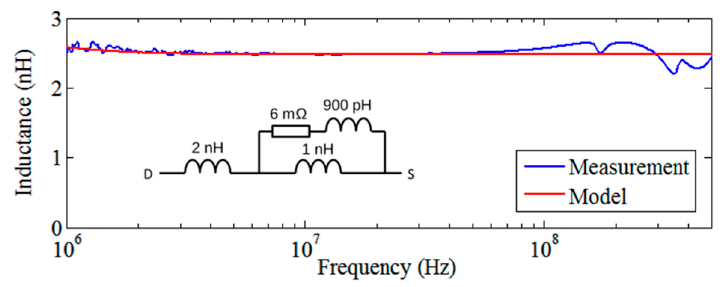
Figure 12. Experimental determination of the drain–source inductance L DS